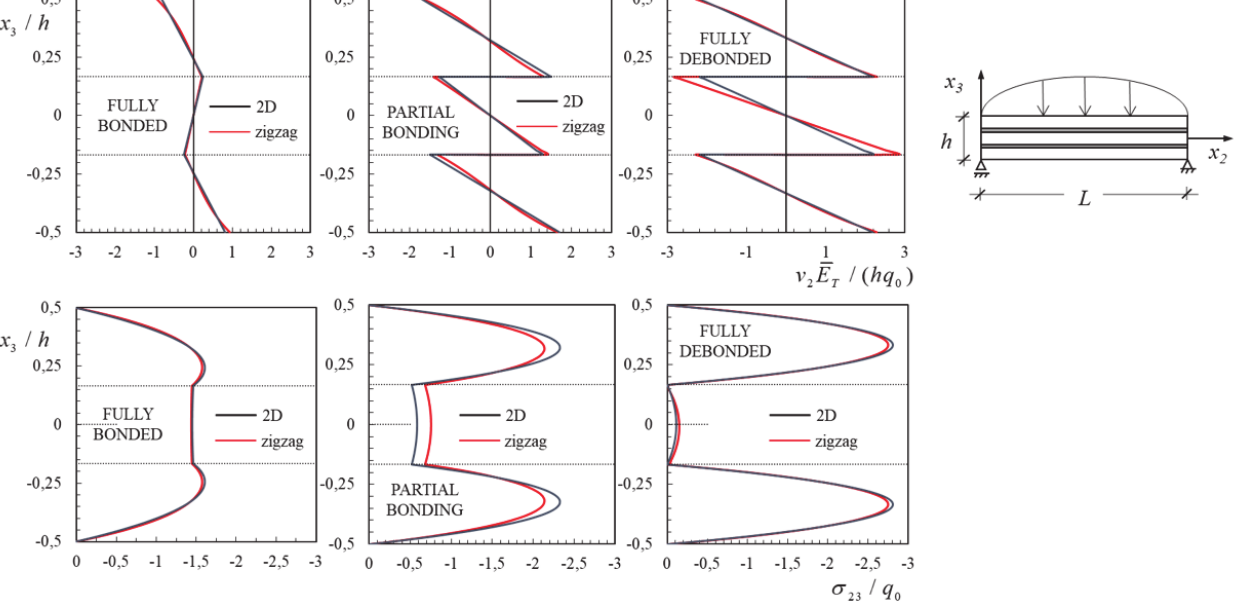
Figure 4: Axial displacements and transverse shear stresses at 2 x L  shown through thickness in a three-layer laminate (0/90/0), thick simply supported wide plate subjected to sinusoidal transverse load, 0 (modified after